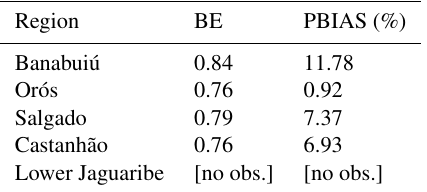
Table 3. Results of regional calibration of the process-based model. BE refers to benchmark efficiency (Eq. 1) and was used for cali- bration; PBIAS is percent bias, i.e. the average tendency for over- or underestimation of simulations in comparison to observations. For Lower Jaguaribe, no observations at the catchment outlet were